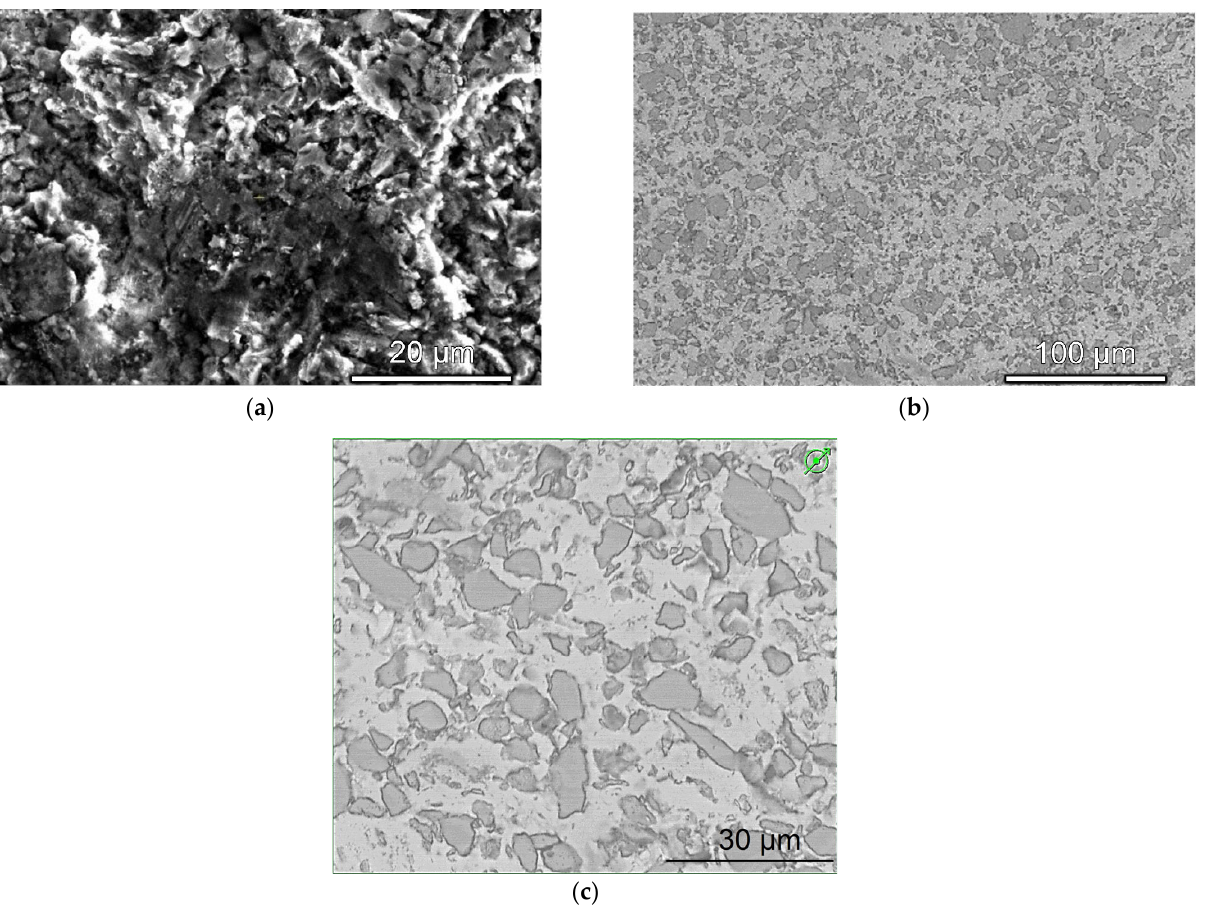
Figure 5. Microstructure of an unpolished surface ( a ) and a polished sample ( b , c ) of an alloy without nanoparticles.